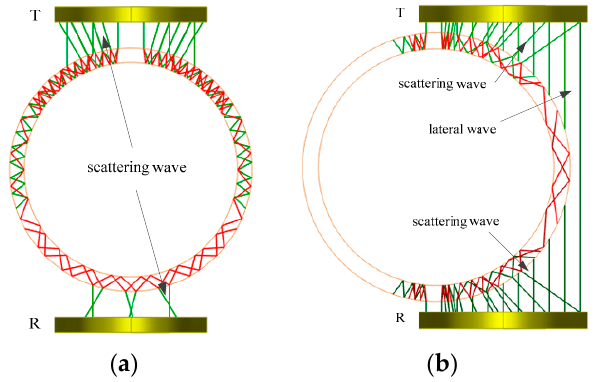
Figure 7. ( a ) The wave propagation when the rod is in the center of the transducers; ( b ) the wave propagation when a part of the rod enters the transducer.